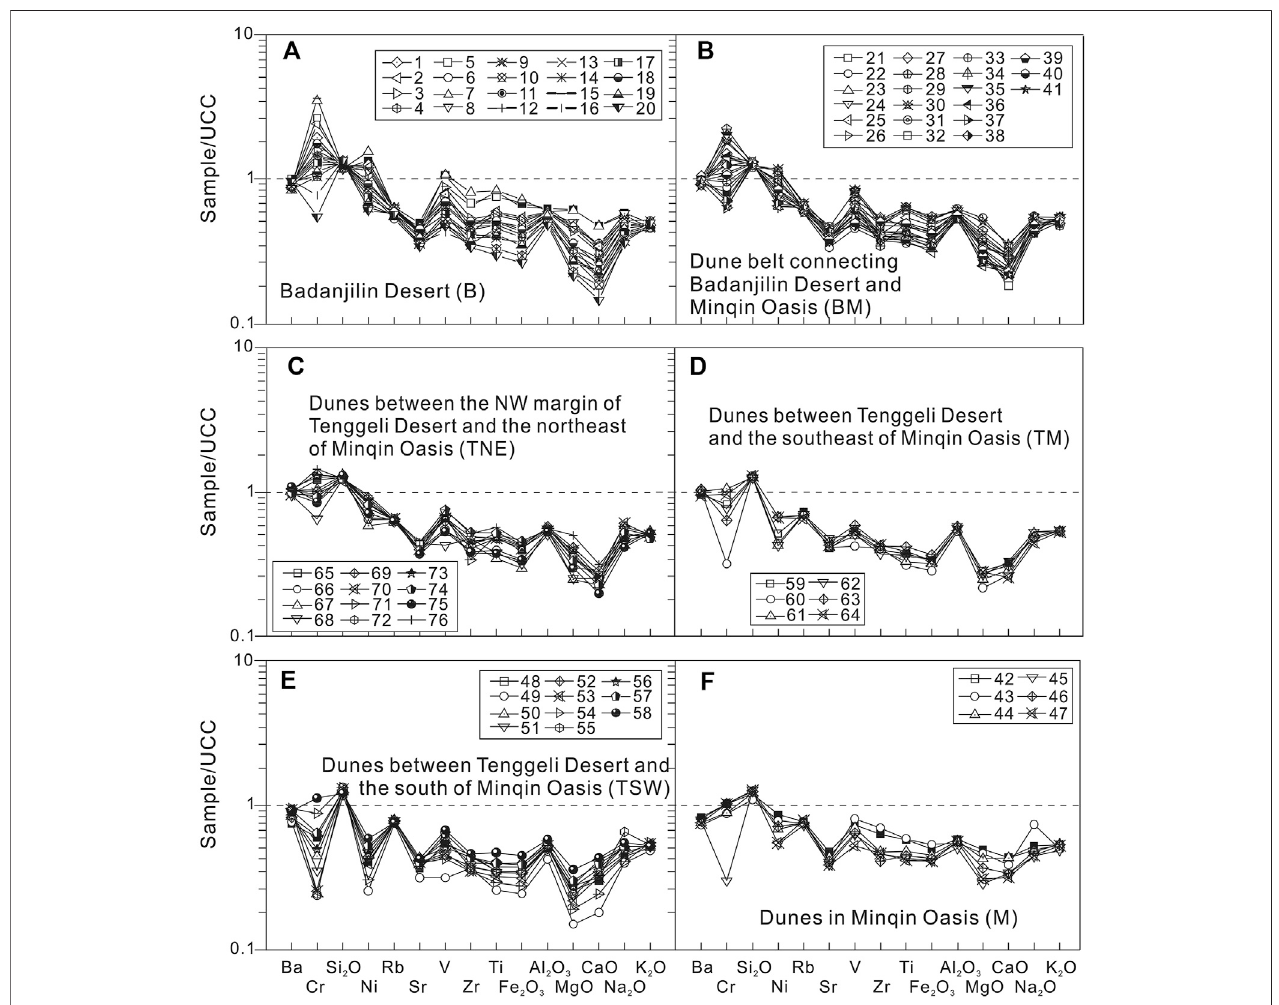
FIGURE6 | TheUCC-standardized distributions and compositionsofmajor and trace elements ofsand dunes in the Minqin Basin and its surrounding areas in the western Hexi Corridor (modi fi ed after Ren et al. (2014)).